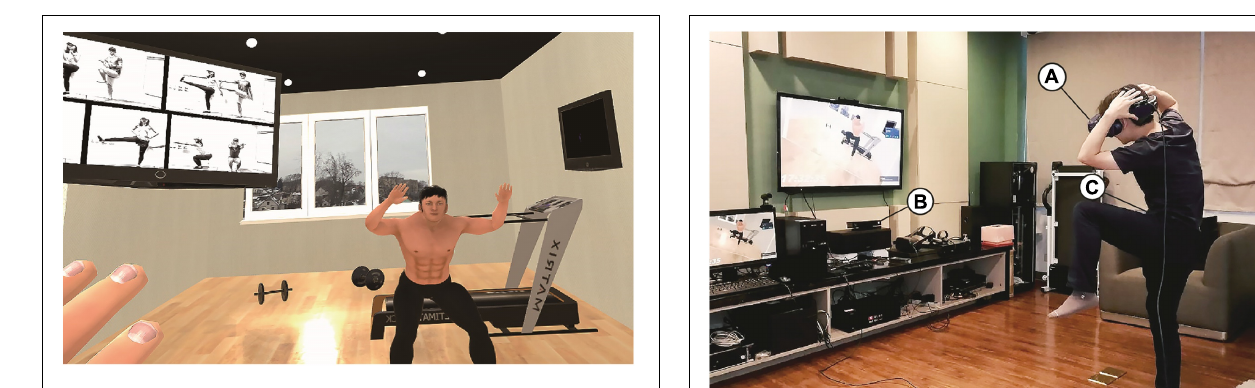
FIGURE 2 | The environment of the virtual gym. The participants could see their virtual body from a first-person perspective and in the mirror.